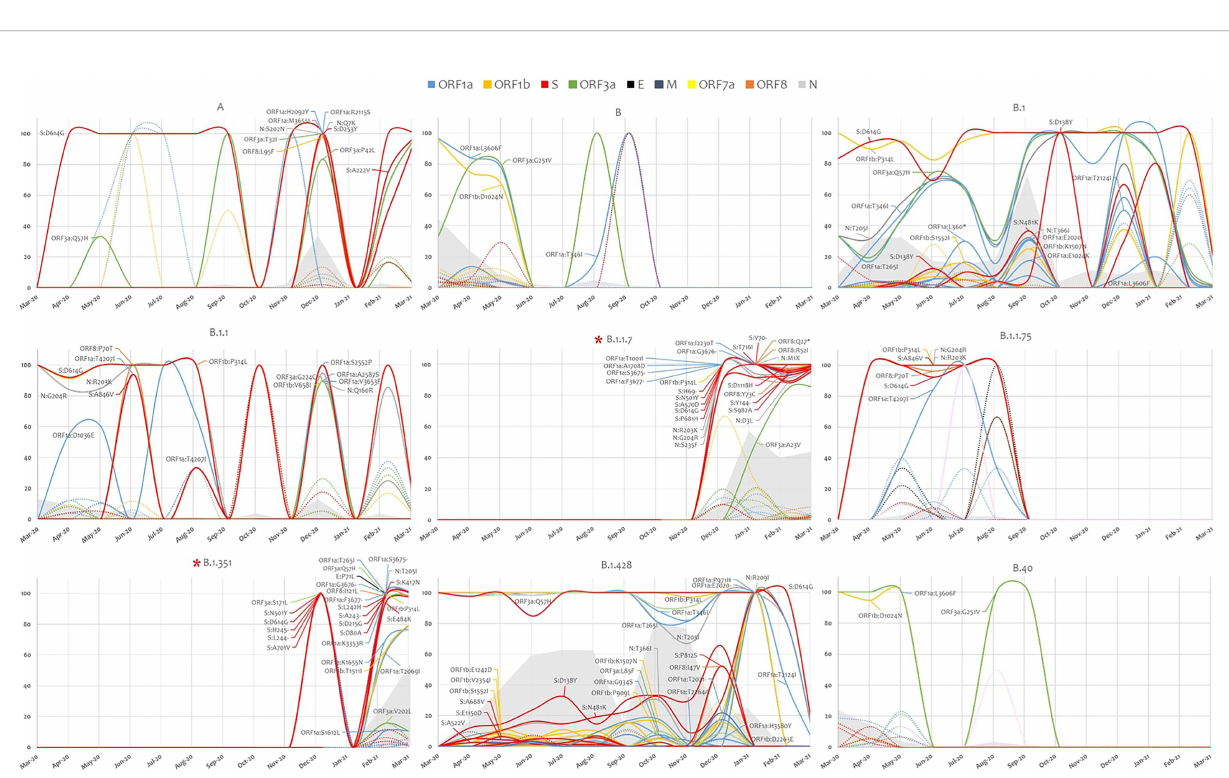
Frontiers in Cellular and Infection Microbiology |